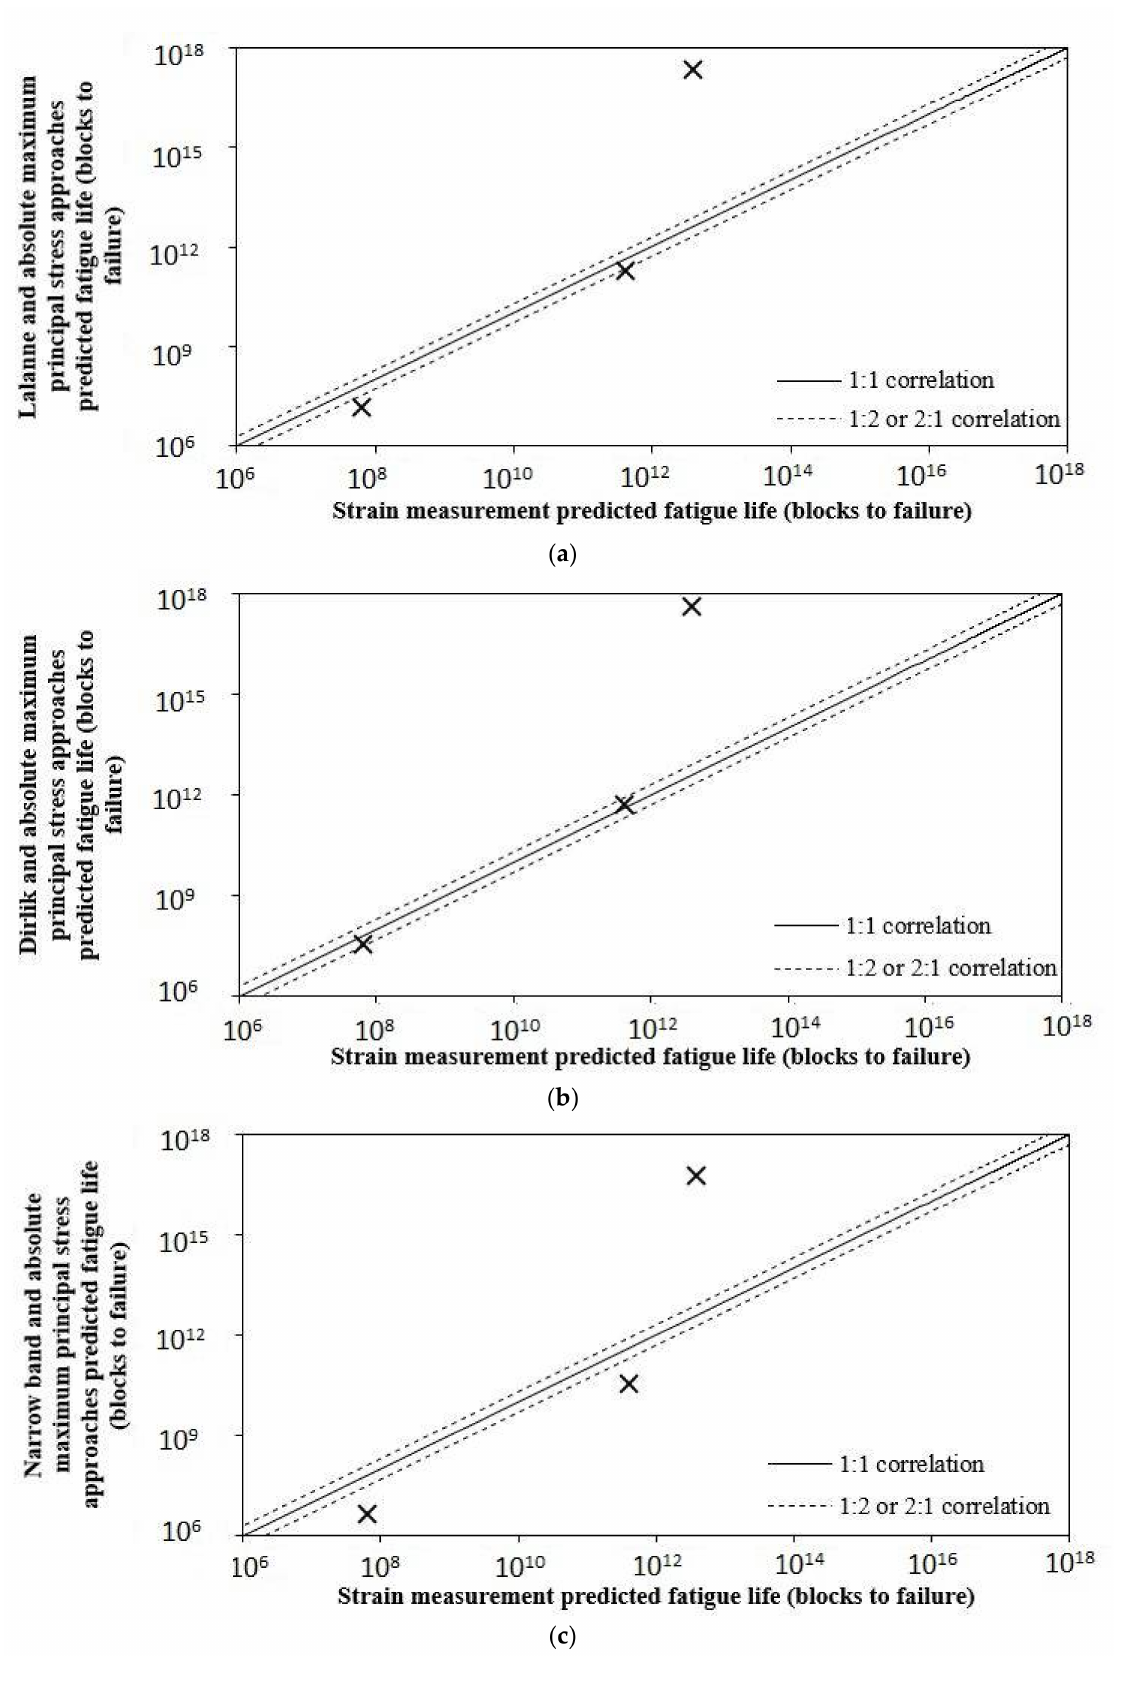
Figure 13. Fatigue life correlation curve using absolute maximum principal stress for different PSD cycle counter method: ( a ) Lalanne; ( b ) Dirlik; and, ( c ) Narrow